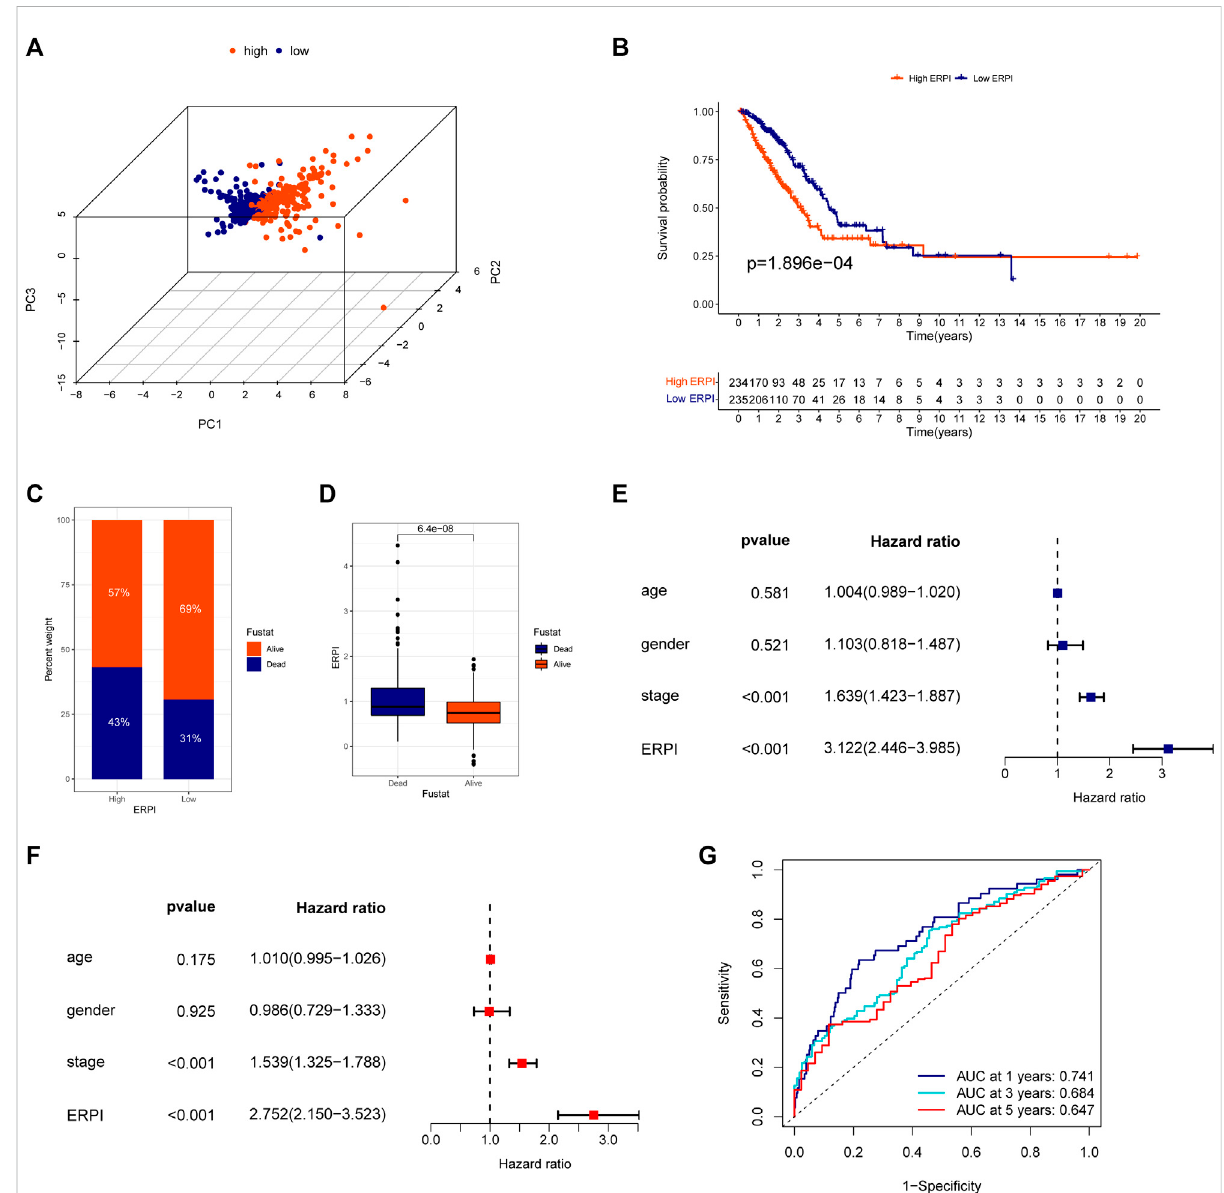
FIGURE 2 Validation of the ERPI in the TCGA dataset. (A) Distribution of high- and low-ERPI groups in PCA based on the expression of 14 EMT-related lncRNAsintheprognosticmodelinTCGA. (B) Survivalcurvesofthehigh-andlow-ERPIgroupsinTCGA. (C) Proportionofdeadandlivingpatientsin the high- and low-ERPI groups in TCGA. (D) ERPI of the dead and living patients. (E) Effect of ERPI and clinicopathological parameters on survival in univariate Cox regression analysis in TCGA. (F) Effect of ERPI and clinicopathological parameters on survival in multivariate Cox regression analysis in TCGA. (G) Time-dependent ROC curves of ERPI in